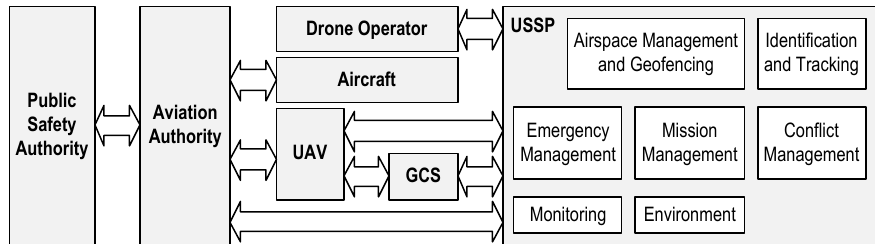
Figure 1. High-level view of the envisioned U-space ecosystem (based on